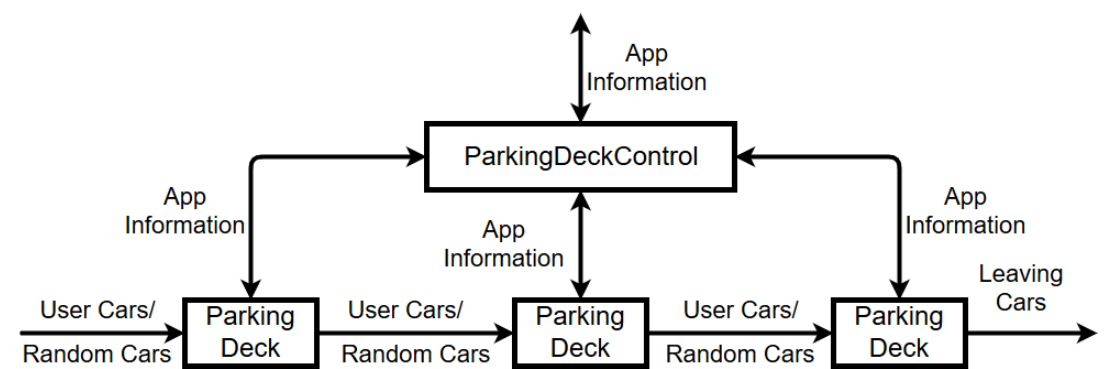
Figure 6. Smart energy use case: Level 1—the parking